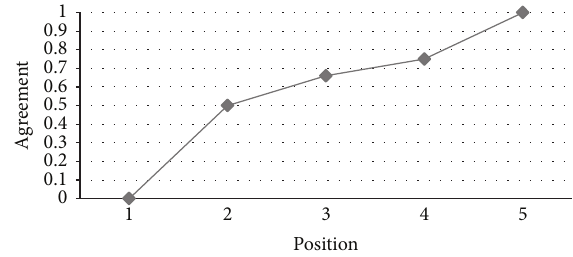
Figure 9: Agreement between the IPA and AHP rankings of nonfunctional requirements.